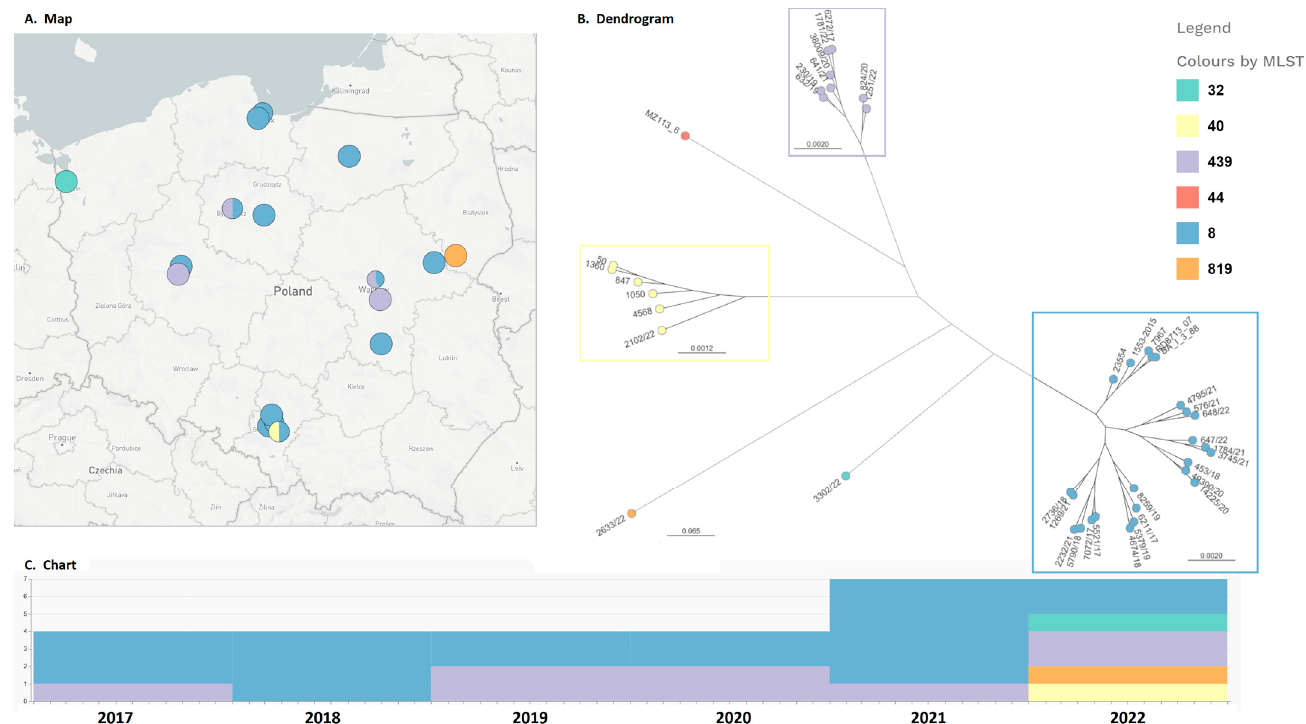
Figure 1. The geographic, time-related, and phylogenetic distribution of the analyzed strains. The whole Microreact analysis is available online (a link to the relevant project is provided in the text).